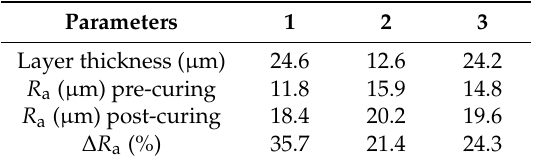
Table 4. Pneumatic spray coating results, PVDF coating on SLS substrates.